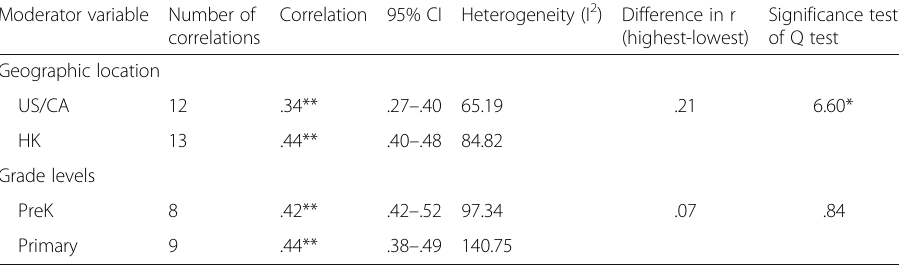
Table 2 Number of correlations, correlation, 95% confidence interval, heterogeneity statistics, difference in r between categories and significance test of categories for moderators of the relationship between Chinese and English phonological awareness Moderator variable Number of Correlation 95% CI Heterogeneity (I 2 ) Difference in r Significance test correlations (highest-lowest) of Q test Geographic